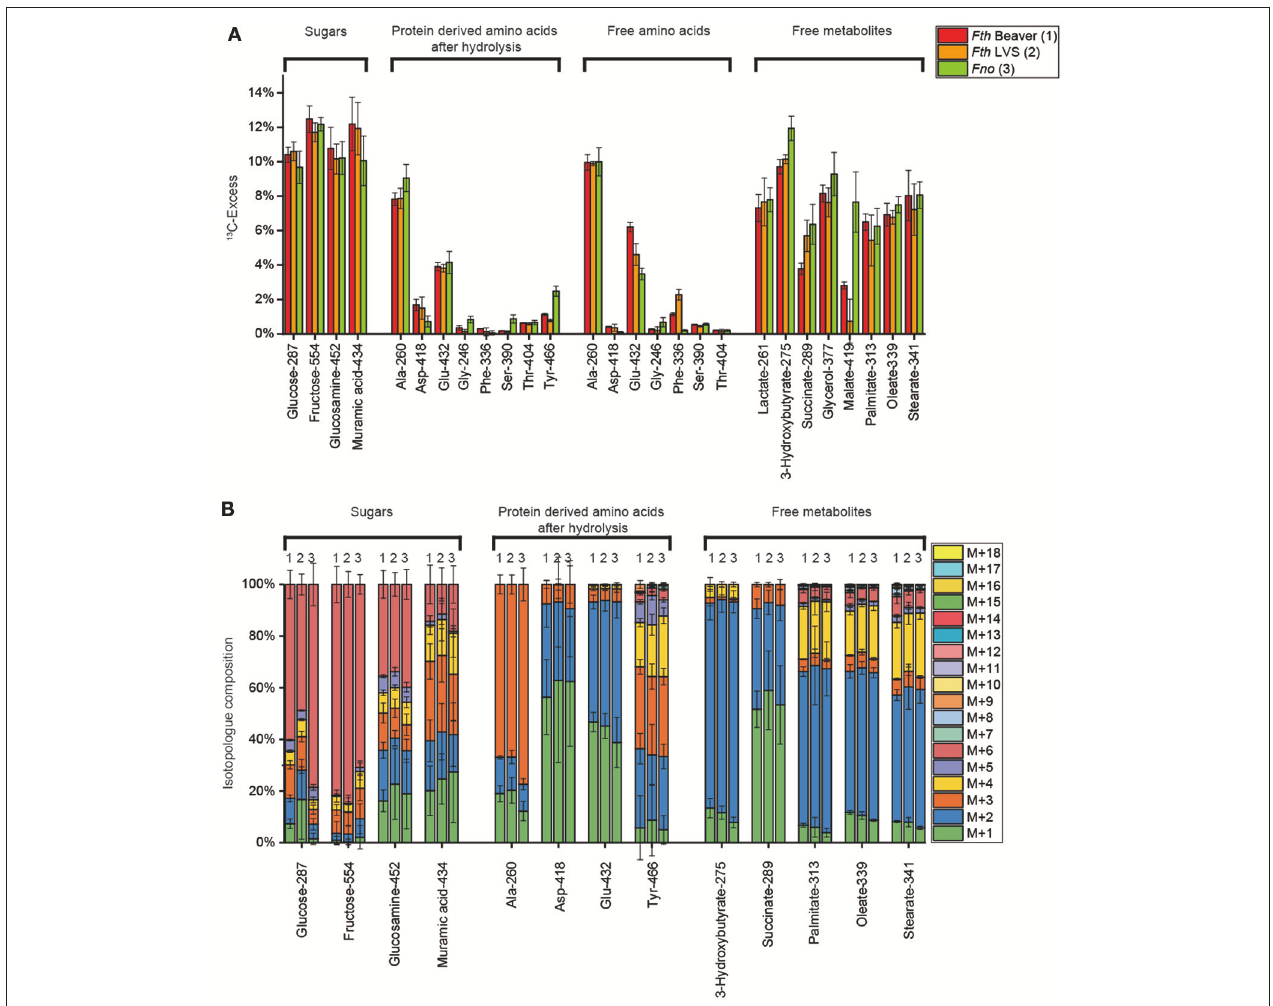
FIGURE 2 | (A) 13 C-Excess (mol%) and (B) the fractional isotopolog distributions (%) in key metabolites of Francisella tularensis subspecies holartica WT strain (beaver isolate) ( Fth Beaver, 1), the Francisella tularensis subspecies holartica life vaccine strain LVS ( Fth LVS, 2), or the less pathogenic Francisella novicida strain U112 ( Fno , 3) grown in medium T supplied with 11 mM [U- 13 C 6 ]glucose. 13 C-Excess (mol%) and relative fractions of isotopologs (%) were determined by GC/MS of silylated derivatives at the indexed m/z values. Error bars indicate standard deviations from the means of 6 to 9 values 2–3 × biological replicates, 3 × technical replicates. M + 1, M + 2, M + 3, etc. indicate isotopologs carrying 1, 2, 3, etc. 13 C-atoms. For numerical values, see Supplemental Tables S1, S5, S9, S13, S17,